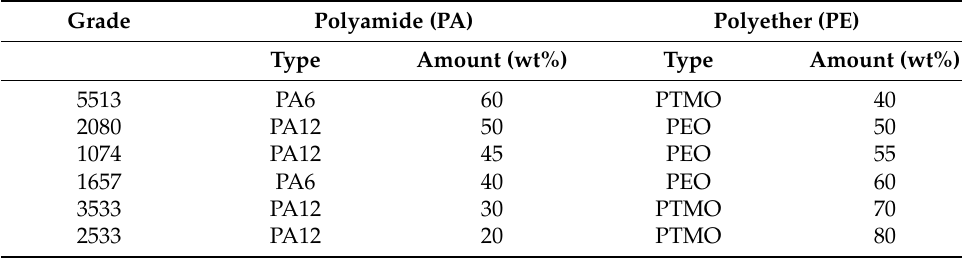
Table 1. Composition of commonly adopted Pebax